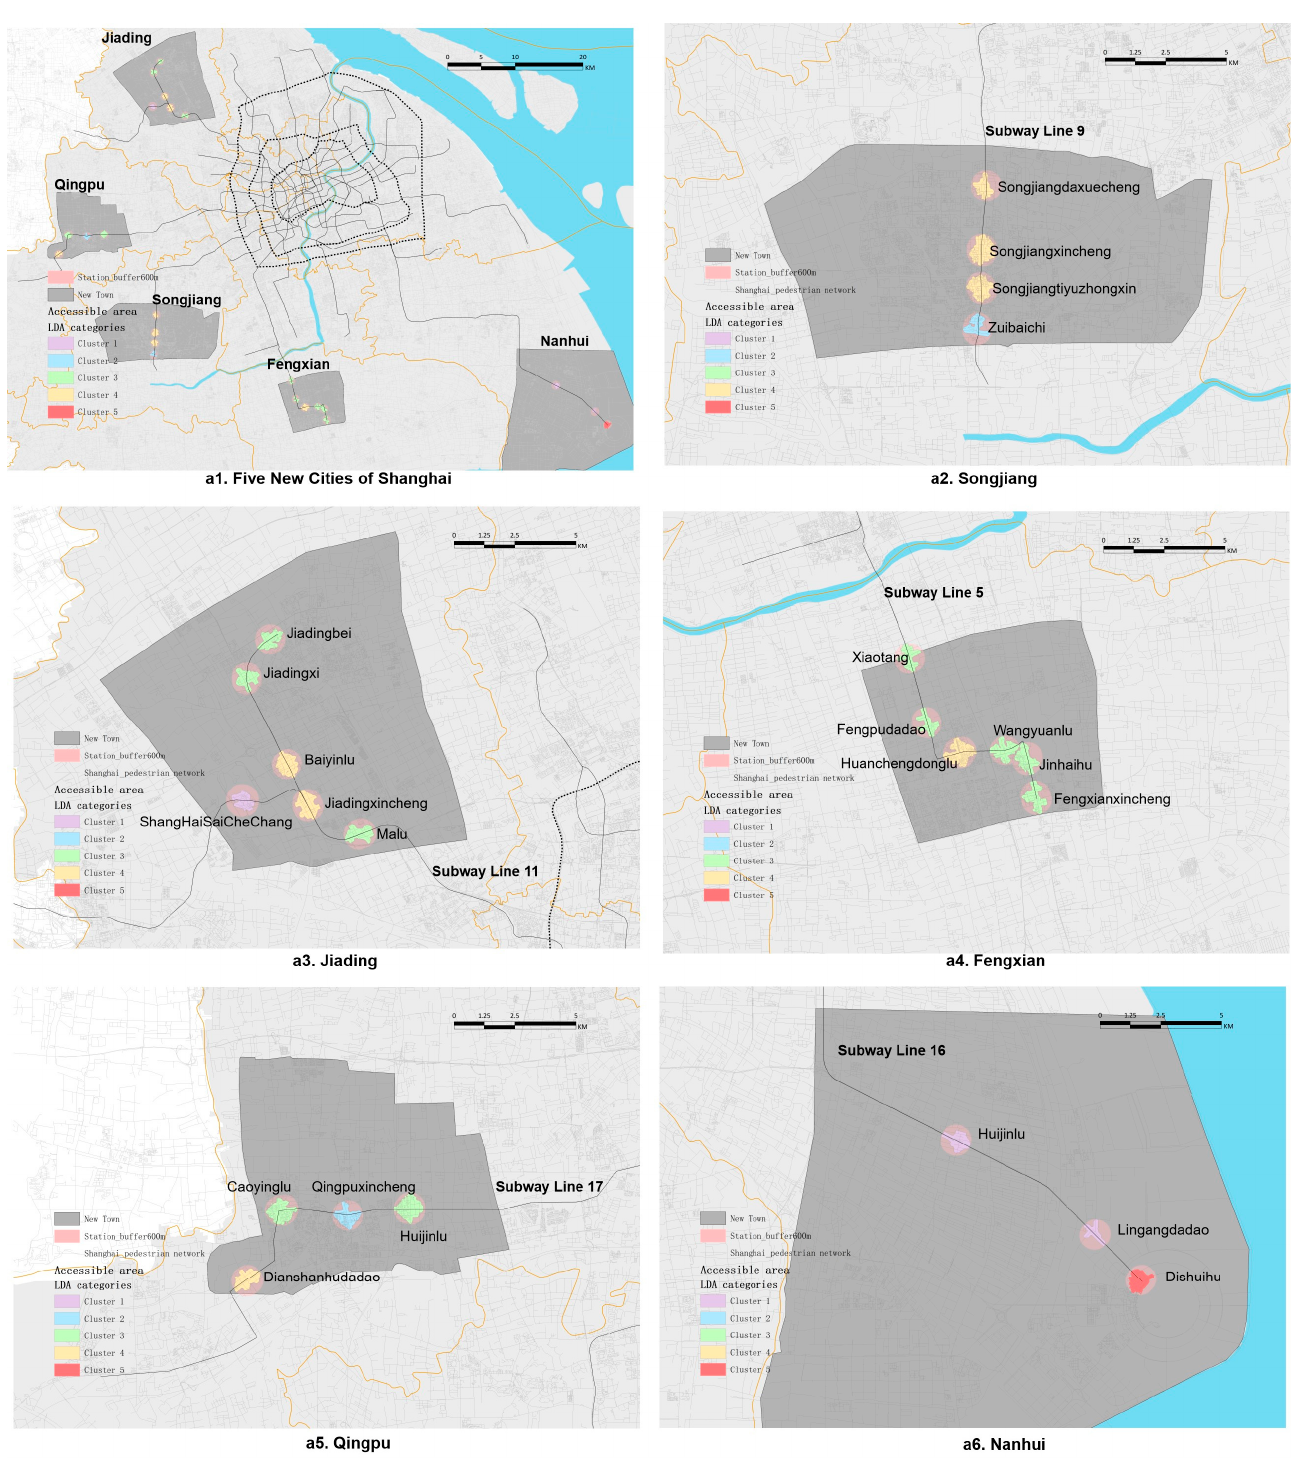
Figure 6. The spatial distribution of aggregated metro stations regarding their thematic topic compositions.